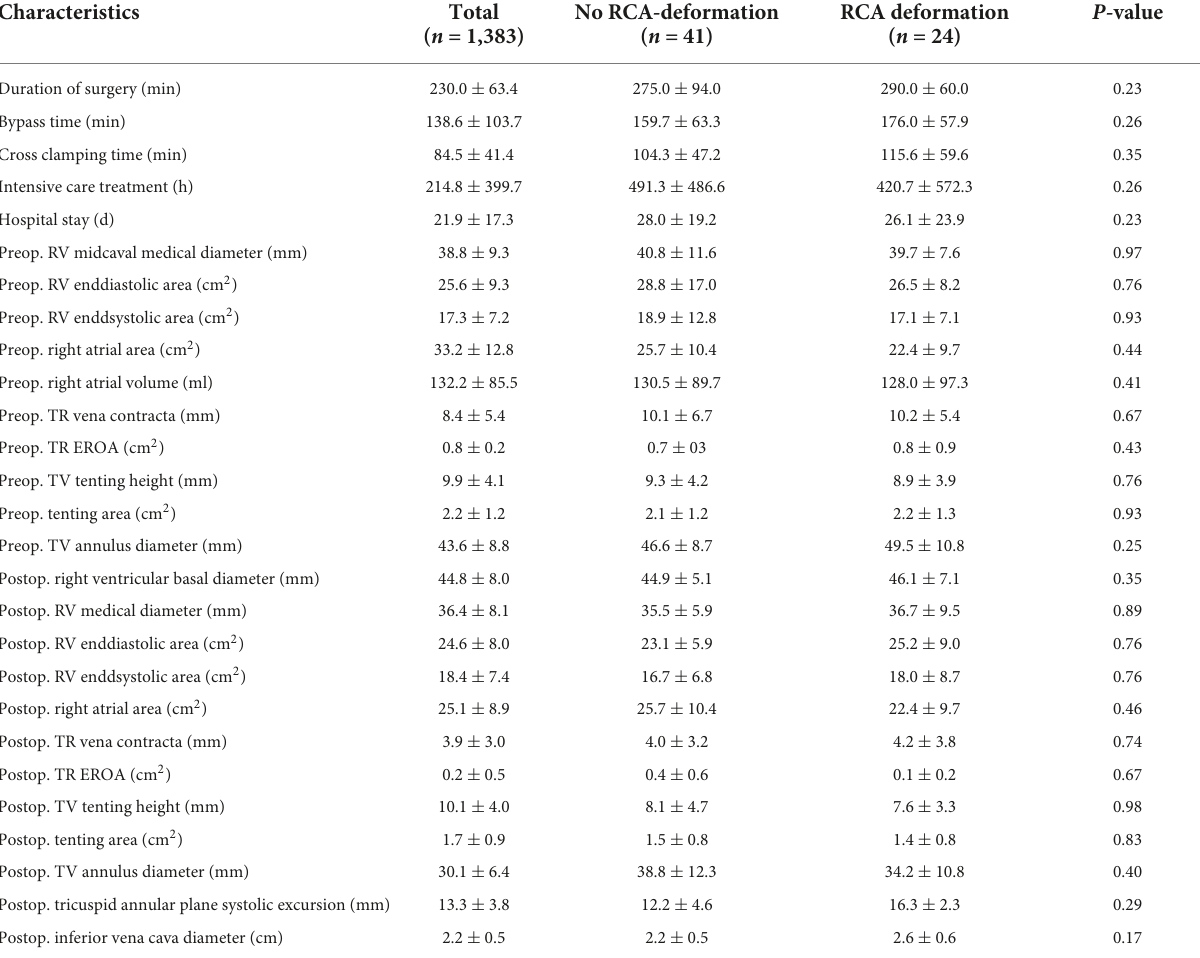
TABLE 2 Pre- and post-operative parameters in patients with and without affection of the right coronary artery. Characteristics